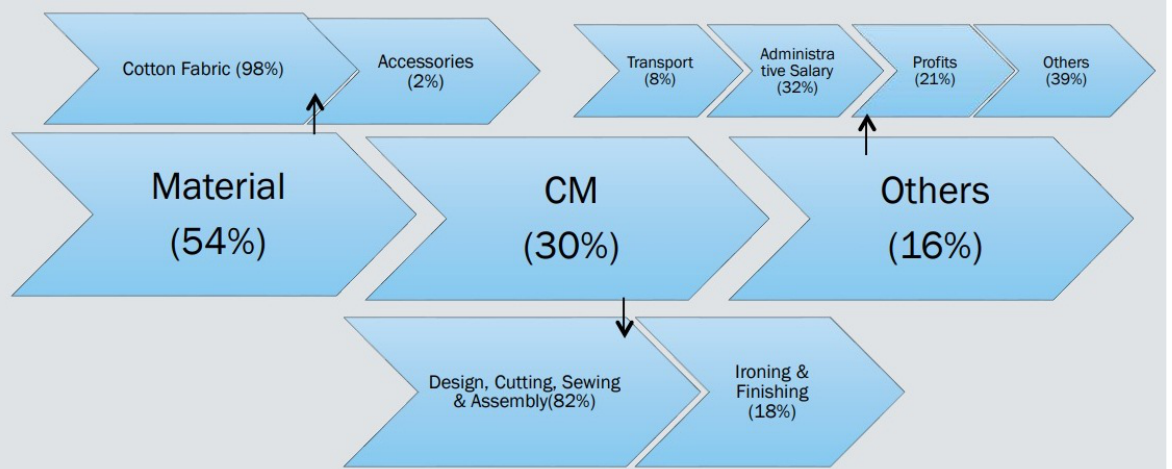
Figure 5: Value creation activities by Bangladeshi Woven Shirt Manufacturers (FOB $4.5) Source: Adapted from “Corporate Governance and Sustainability of the Global Value Chain: Bangladesh Ready-Made Garment Industry”, by Nachum et al., 2017,